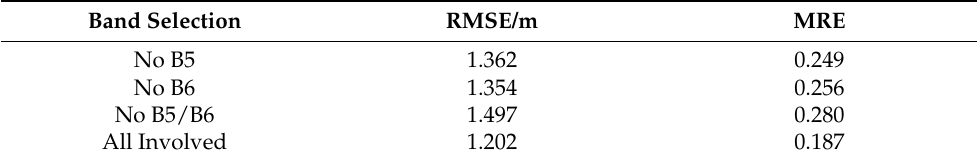
Table 3. Inversion Results of Water Depth Affected by “Red Edge” Waveband.